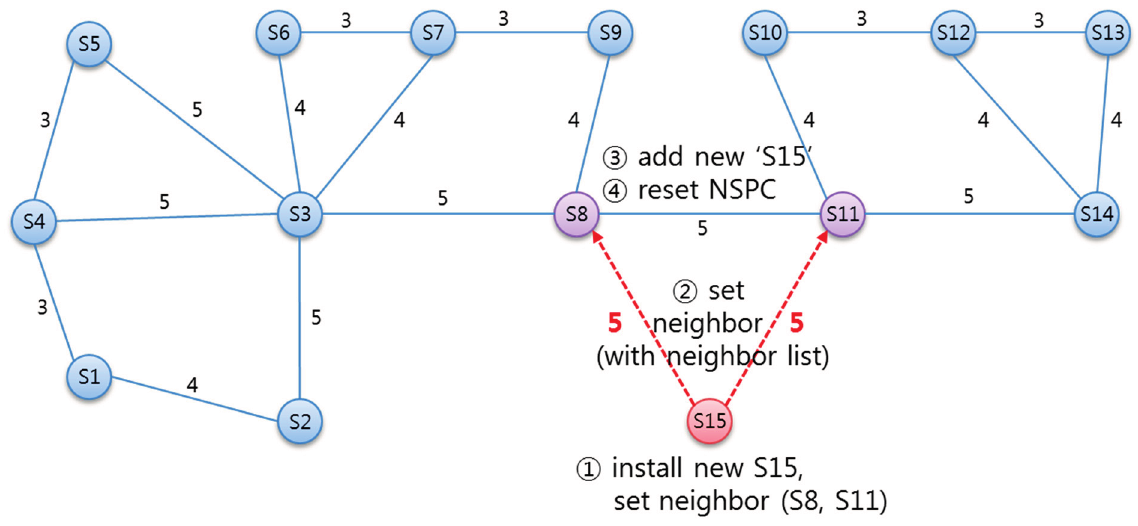
Figure 12. The state diagram for installing a new SLiM